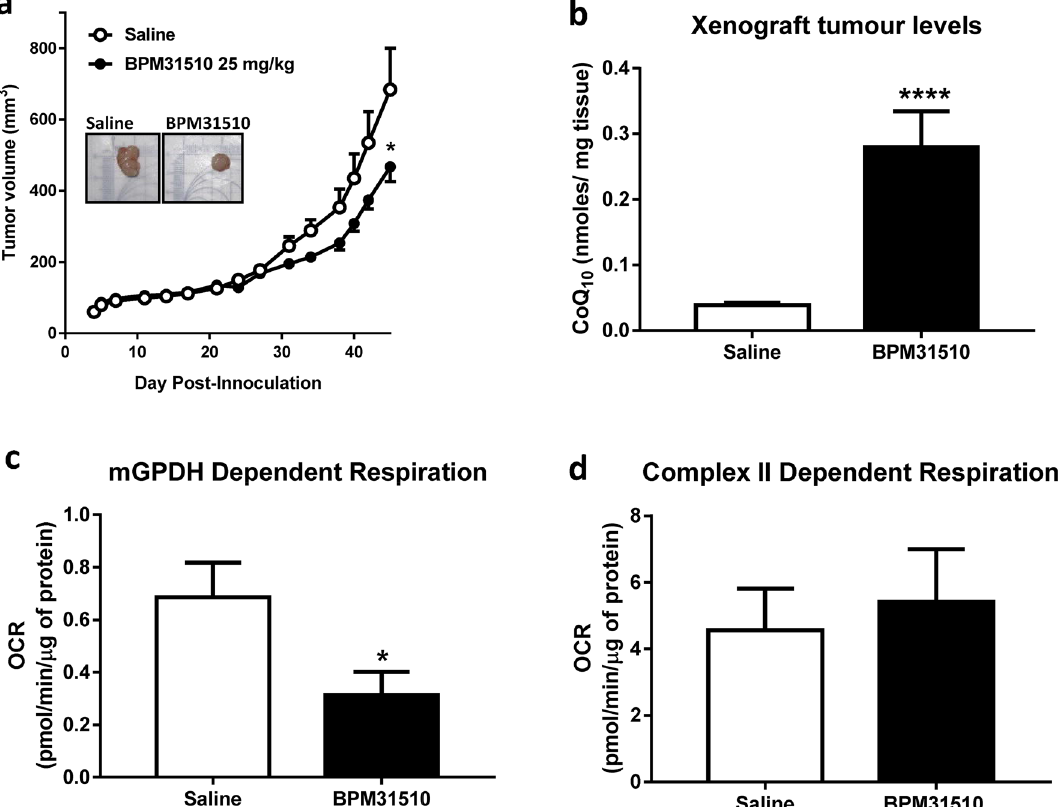
Figure 6. BPM31510 affects tumour size and alters mitochondrial respiration in vivo in a MIA PaCa-2 xenograft mouse model of pancreatic cancer. ( a ) BPM31510 (25 mg/kg, i.p., B.I.D.) effects on tumour volume in an MIA PaCa-2 xenograft pancreatic mouse model. Representative tumours from an untreated control and BPM31510-treated mouse are shown (inset). The data were analysed by Student’s t test; * p < 0.05 compared to control mice. ( b ) CoQ 10 levels in tumours after BPM31510 treatment. Data represent n = 11 saline-treated mice and n = 12 BPM31510-treated mice. Data were analysed by Student’s t test. * p < 0.05 vs control. ( c , d ) BPM31510 effects on ( c ) state 3 G3PDH respiration and (d) state 3 Complex II respiration in MIA PaCa-2-derived epithelial cancer cells enriched from excised xenografts. N = 6 per group. The data represent the means + SEM and were analysed by a Mann–Whitney non-parametric test; **** p < 0.0001 compared to